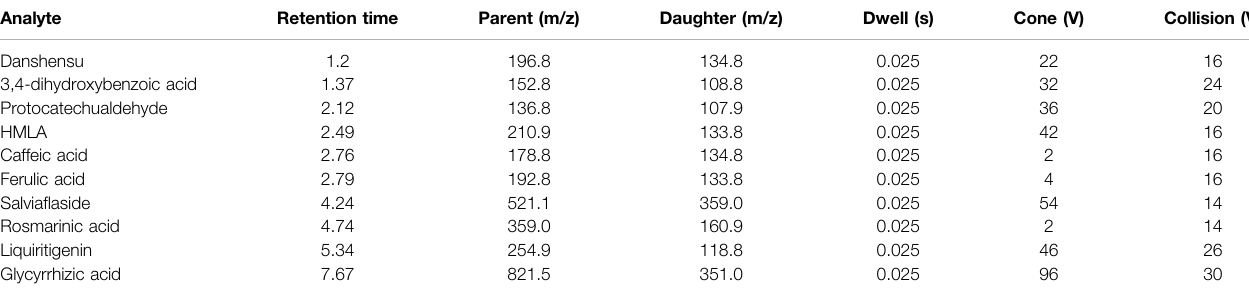
TABLE 1 | MS/MS transitions and parameters for the detection of the 10 standards. Analyte Retention